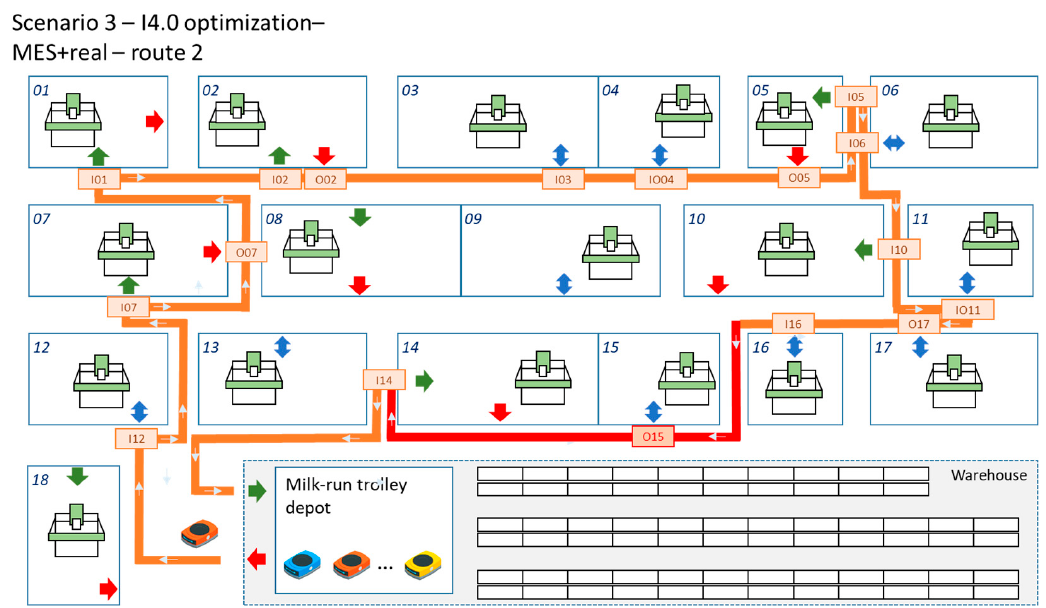
Figure 12. The modified second route of the I4.0 technologies supported real-time milk-run-based in-plant supply including MES data-based supply demands and digital-twin-generated real-time supply demands. Red lines of the route represent the real-time added route segments. Table 10. Numerical results of the scheduling of predefined and real-time-generated specific in- plant material supply operations performed by the milk-run trolley within route 2. The colored rows represent the real-time added supply demands generated by the supervisory level using the results of the optimization based on the digital twin model.